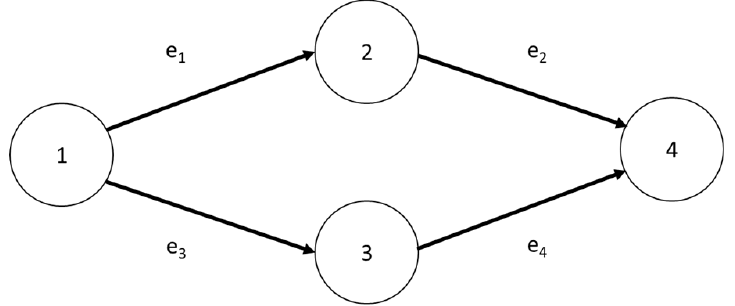
Figure 10. Single-time window and single service network.